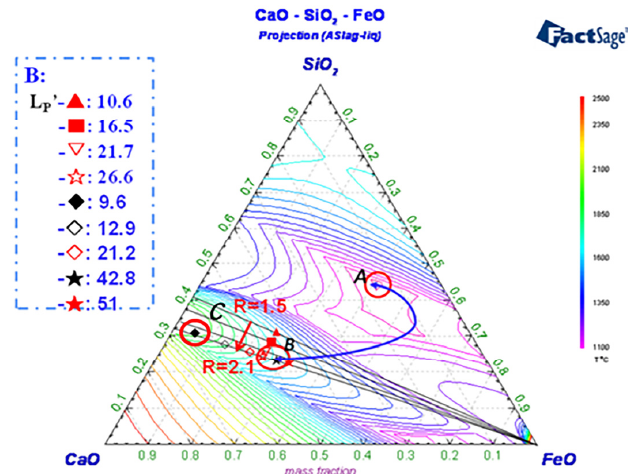
Figure 8. The actual slag-forming route of dephosphorization.